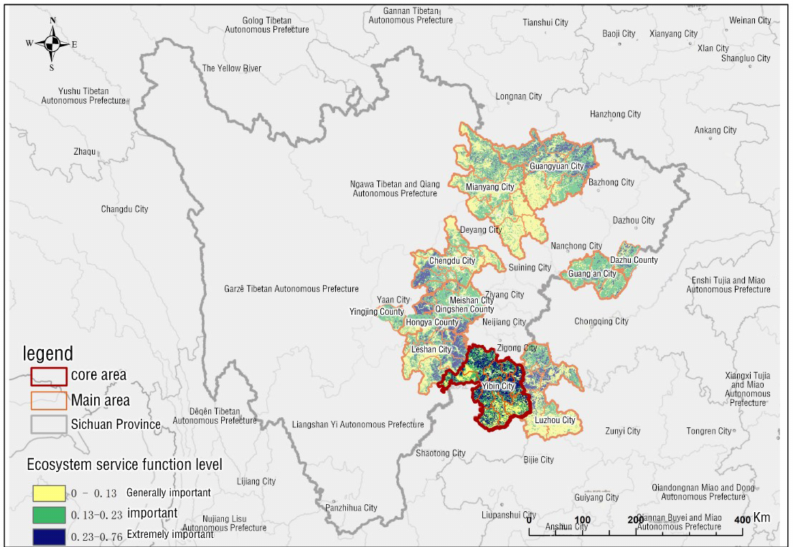
Figure 12. Distribution of the importance of ecosystem services in research areas of Sichuan